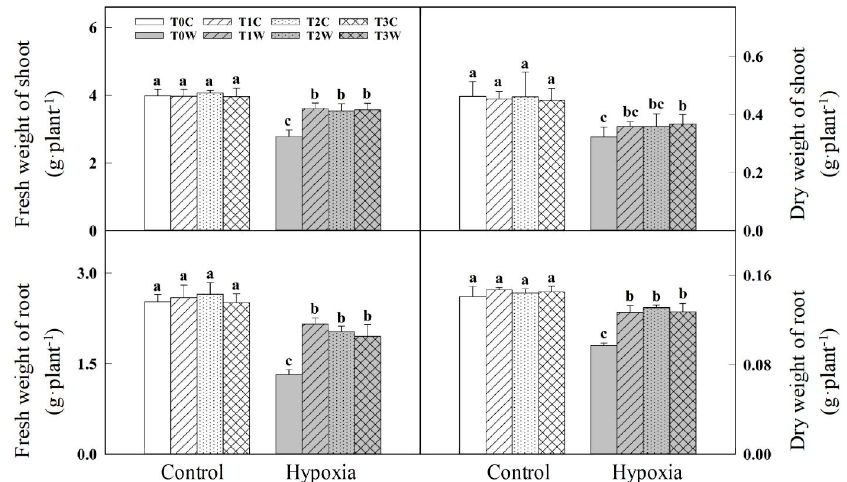
Figure 1. Effects of waterlogging priming on plant biomass accumulation of offspring plants under hypoxia stress in wheat seedling. Note: T0C, no priming + no offspring hypoxia stress; T0W, no priming + offspring hypoxia stress; T1C, one-generation priming + no offspring hypoxia stress; T1W, one-generation priming + offspring hypoxia stress; T2C, two-generation priming + no offspring hypoxia stress; T2W, two-generation priming + offspring hypoxia stress; T3C, three-generation priming + no offspring hypoxia stress; T3W, three-generation priming + offspring hypoxia stress. Data are means ± SE (n = 3). Different lowercase letters indicate the significant difference at p < 0.05 level.